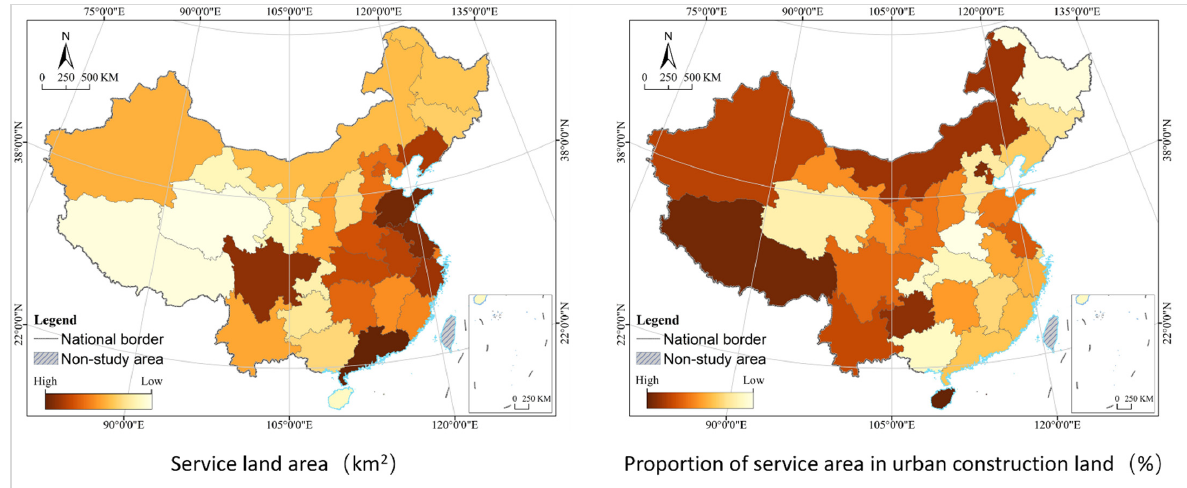
Figure 3. Comparative analysis on the scale and proportion of urban service-land.